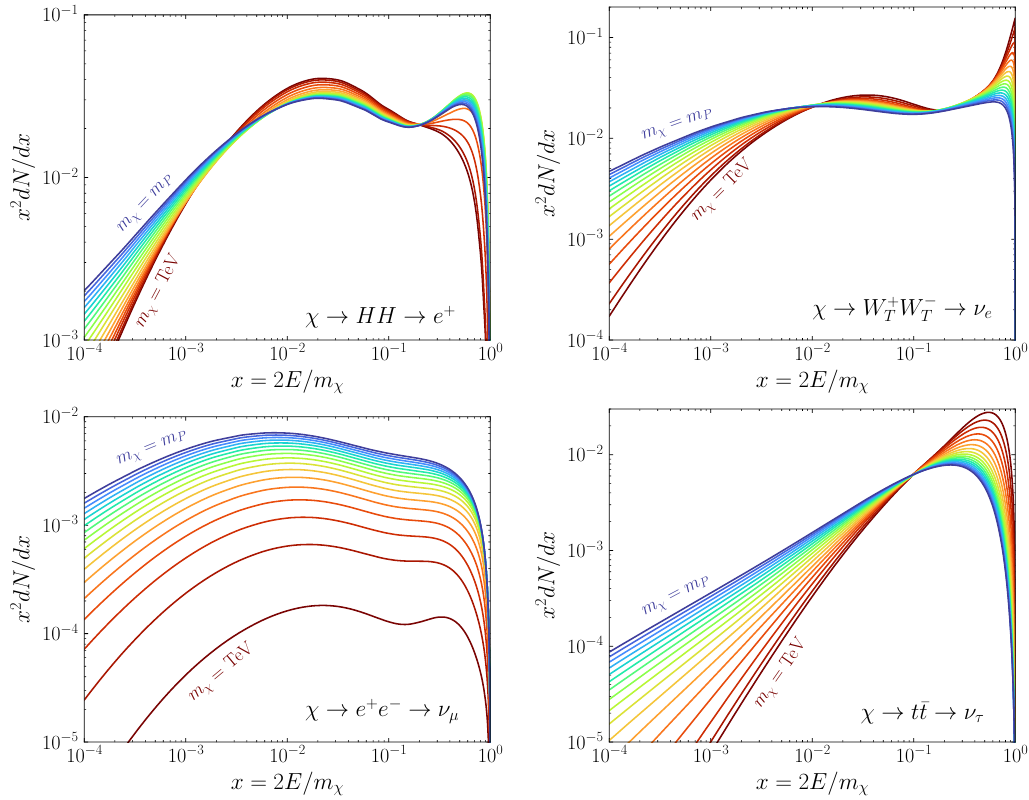
Figure 12 . Analogs of figure 3 for four additional DM decay processes: higgs to positrons (top left), transverse W -bosons to electron neutrinos (top right), electrons to muon neutrinos (bottom left), and top-quarks to tau neutrinos (bottom right). Each figure shows the spectra for each decade of DM mass between m = 1 TeV and 10 19 GeV. Further, initial helicities or polarizations are averaged χ over, where